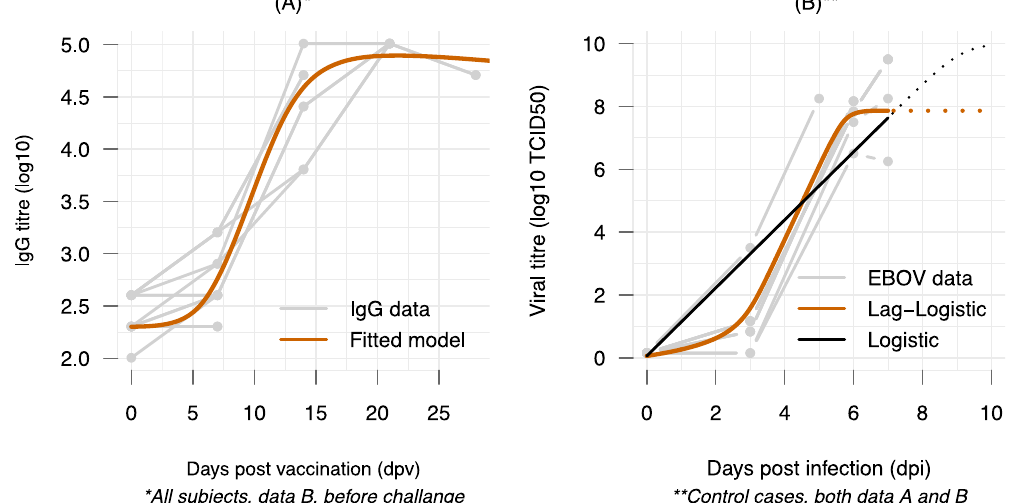
Figure 2. Fitting models to the IgG and viral titer data. Gray lines are subject-specific data. ( A ) Data of the IgG titer post vaccination and prior to EBOV challenge were used to fit to the model of antibody responses. The fitted values of the model were superimposed (orange line) illustrating a general profile of the IgG dynamic after exposure to EBOV. ( B ) Viral titers in control cases form both data sources 10, 11 were used to evaluate EBOV replication models in treatment-free scenarios. The follow-up data were stopped when the animals reached the endpoints to be euthanized 10, 11